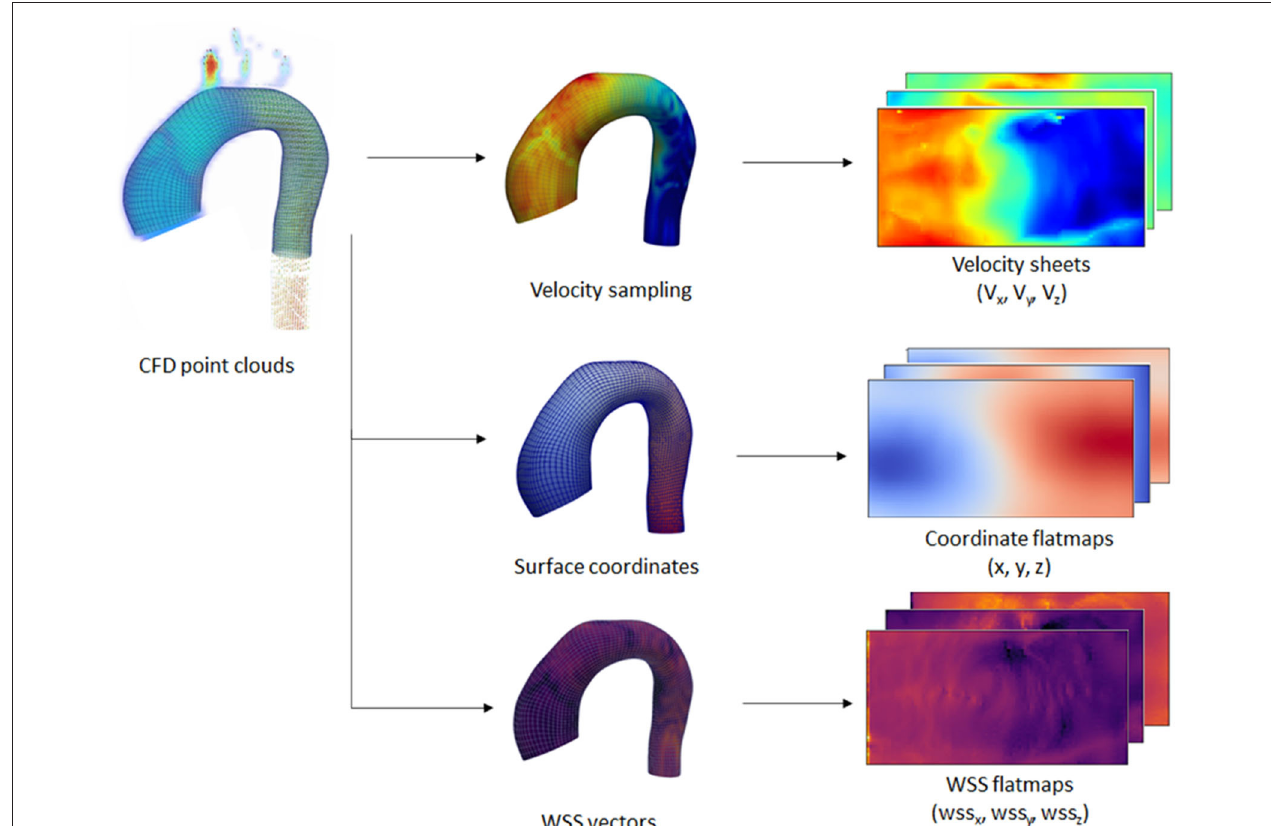
FIGURE 3 | Overview of the extraction process performed on the CFD point clouds dataset. Extraction was performed on the wall coordinates and several inner surface coordinates. Wall shear stress (WSS) vectors and velocity vectors were extracted at the wall and inner coordinates, respectively. The extracted information was transformed into 2D flatmaps based on the template mesh.